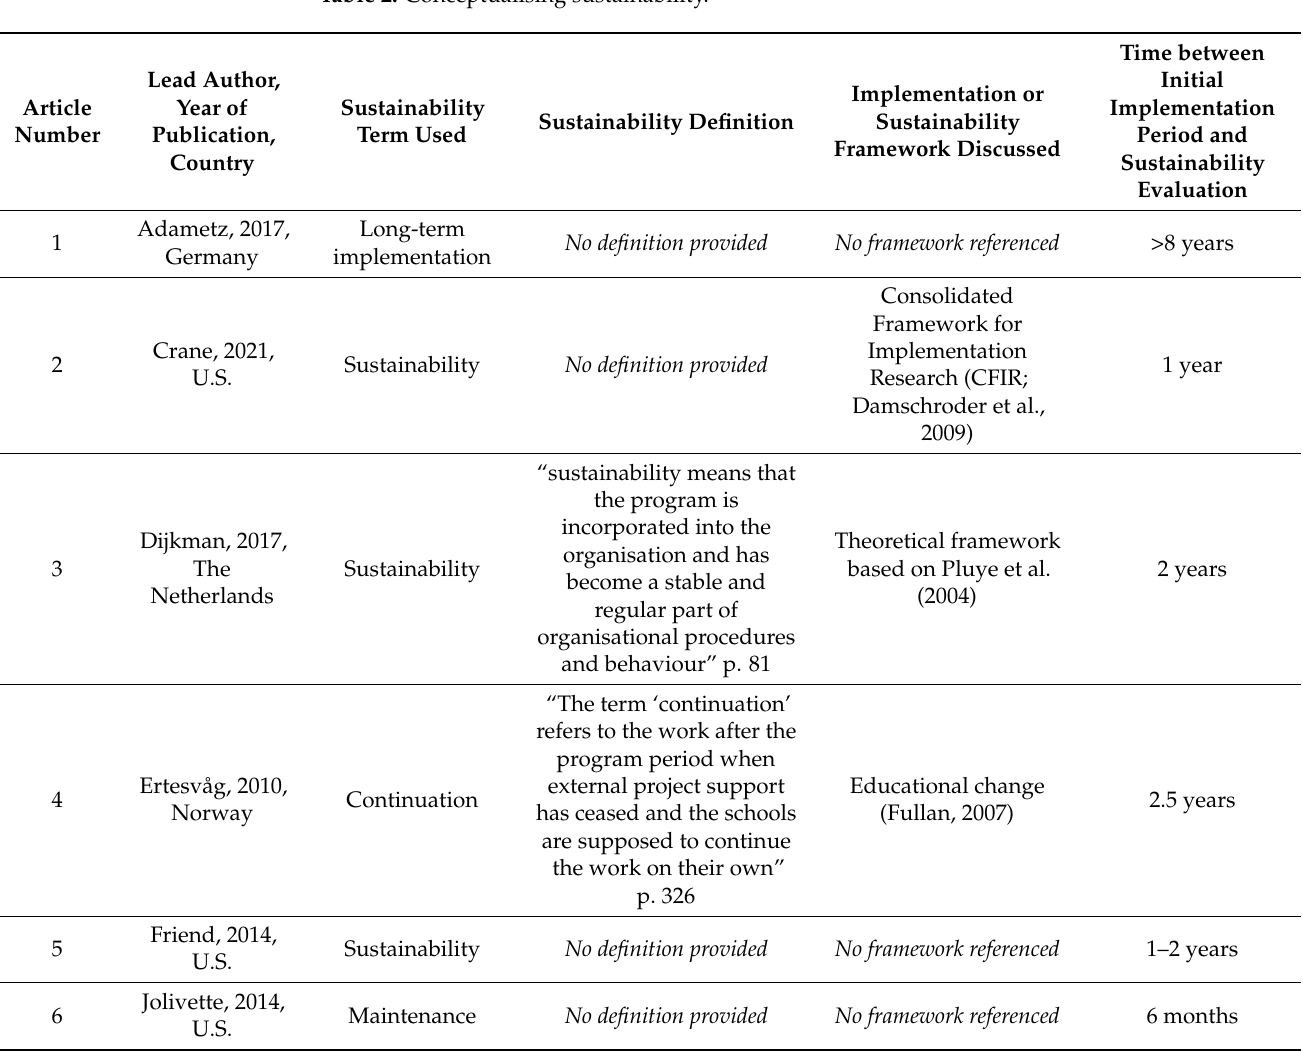
Table 2. Conceptualising